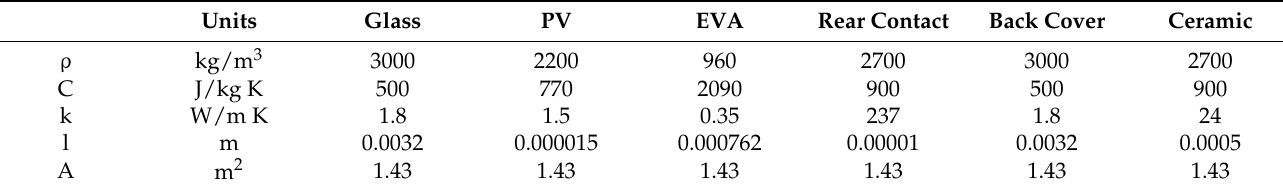
Table 2. Design parameters of PV and thermos physical properties of the layer [21].